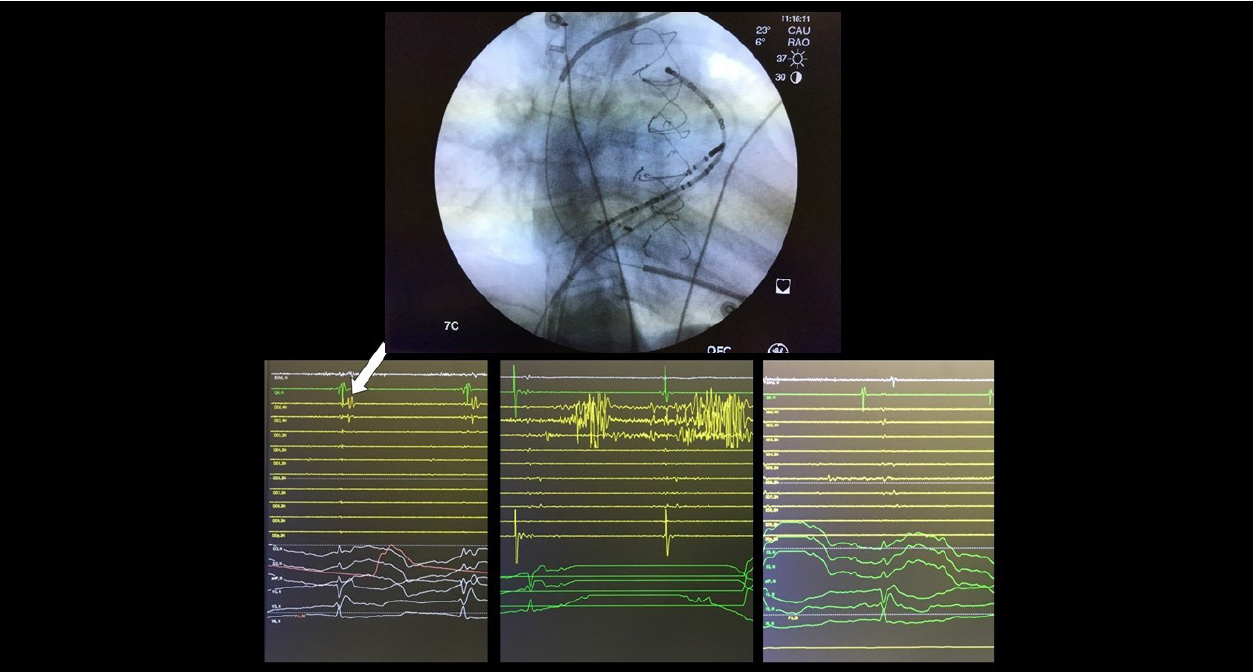
Fig. 3 – Ablation lines between landmarks successfully interrupting VT circuit (On fluoroscopy we can see a 20-pole deflectable catheter along isthmus number 3. A pig tail catheter was used to mark the pulmonary prosthesis. On the lower panels ablation of late fragmented late potentials (arrow) along the 20-pole deflectable catheter between the VSD patch and pulmonary prosthesis (lower left before ablation, middle during ablation and right lower after completion of the line). Other radiofrequency delivery was performed in order to extinguish any late potentials observed along that